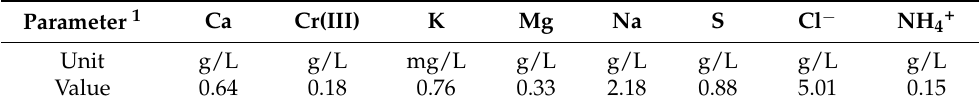
Table 1. Chemical composition of the concentrate obtained by processing of a synthetic effluent with an RO SW30 membrane [12], at pH 3.6 and T = 20 ◦ C. Parameter 1 Ca